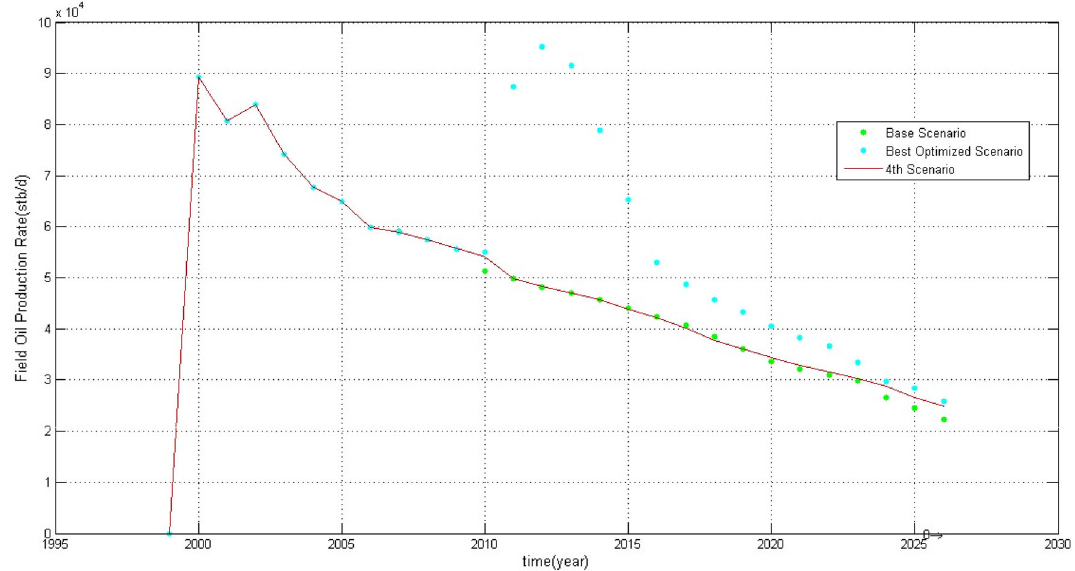
Fig. 9 Field production rate of fourth